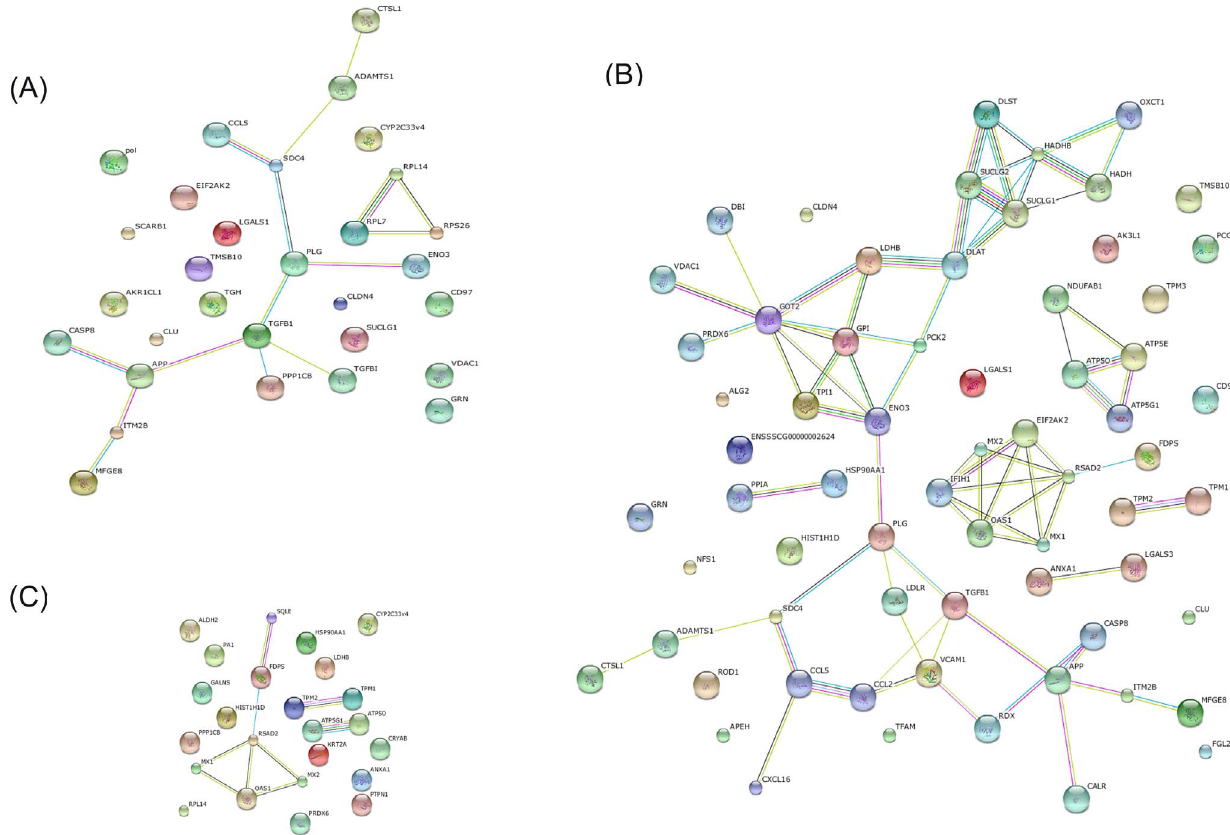
Figure 4. Protein-protein interaction network created using the STRING database. (A) Network of the differentially expressed proteins at 48 hpi. The network includes 30 nodes (proteins) and 15 edges (interactions). (B) Network of differentially expressed proteins at 64 hpi. The network includes 66 nodes and 70 edges. (C) Network of differentially expressed proteins between the two time points. The network includes 24 nodes and 9 edges. Network analysis was set at medium confidence (STRING score=0.4). Seven different colored lines were used to represent the types of evidence for the association: green, neighborhood evidence; red, gene fusion; blue, co-occurrence; black, co-expression; purple, experimental; light blue, database; yellow, text mining.